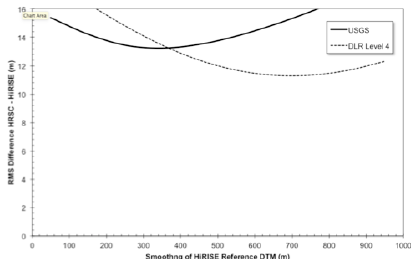
Figure 5. Standard deviation of the difference between USGS and HRSC Team Level 4 DTMs for rugged terrain on Aeolus Mons. Error level for the products is similar when evaluated at 350 m smoothing, suggesting they simply make different trades between resolution and precision.